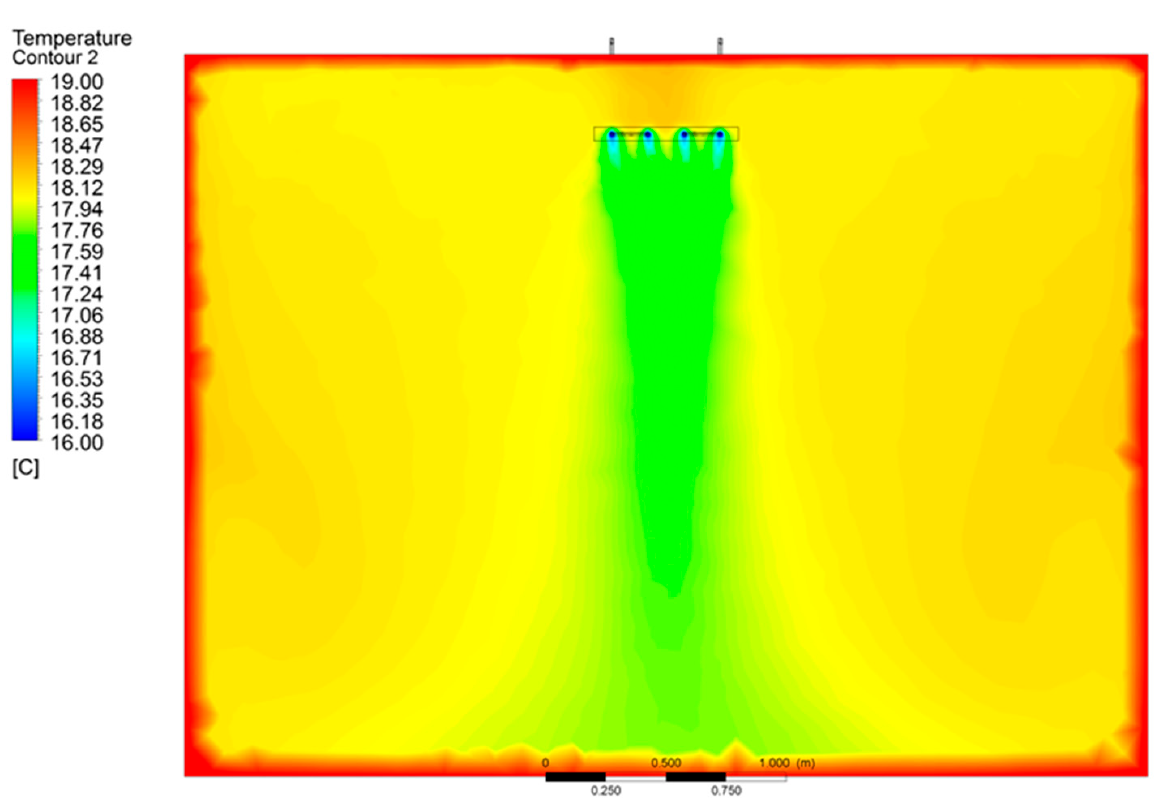
Figure 20. Model of passive cooling beam—the contours of velocity (m/s).